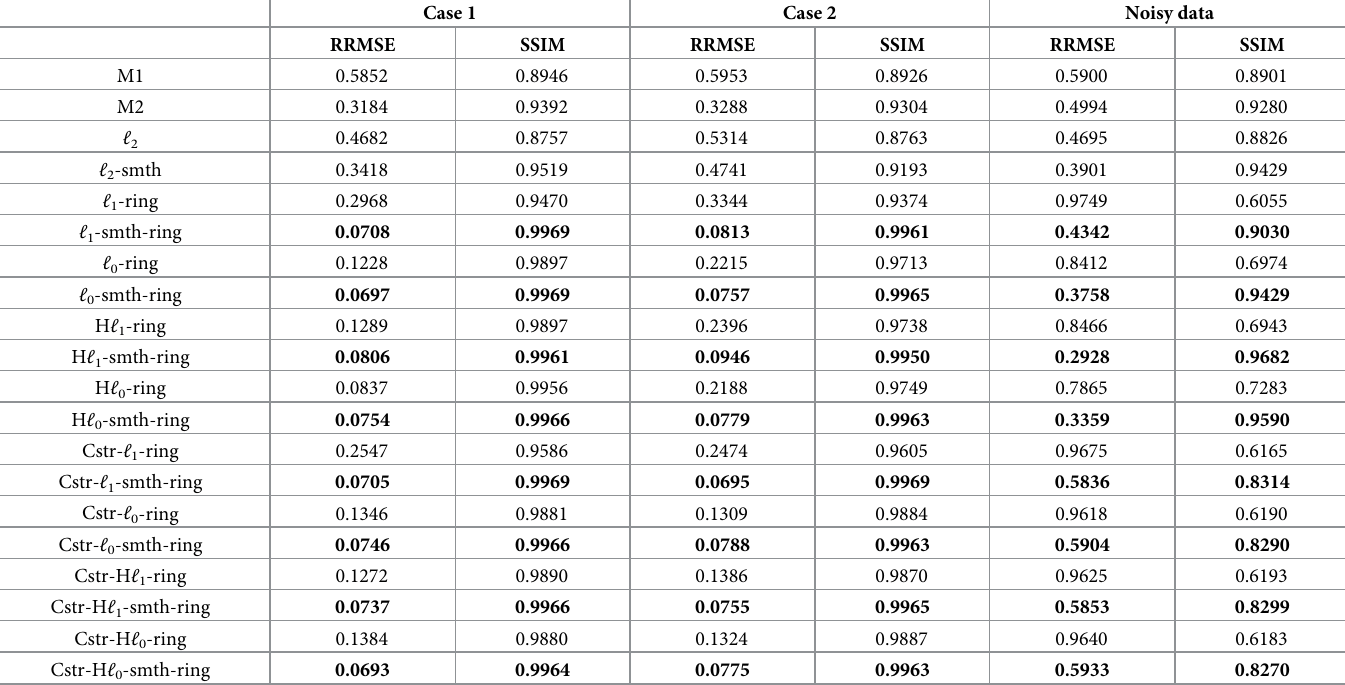
Table 2. RRMSE and SSIM values of reconstructed images by the proposed algorithms and the compared methods for the first and second study cases and the noisy data.